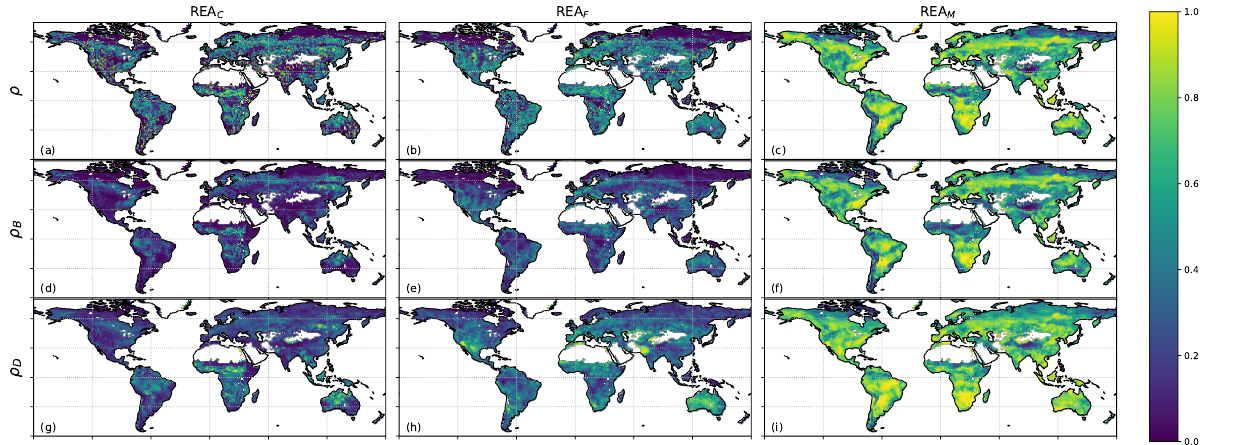
Figure 5. Collective model reliability ρ , model performance ρ B and model convergence ρ D (row-wise) for REA C , REA F and REA M